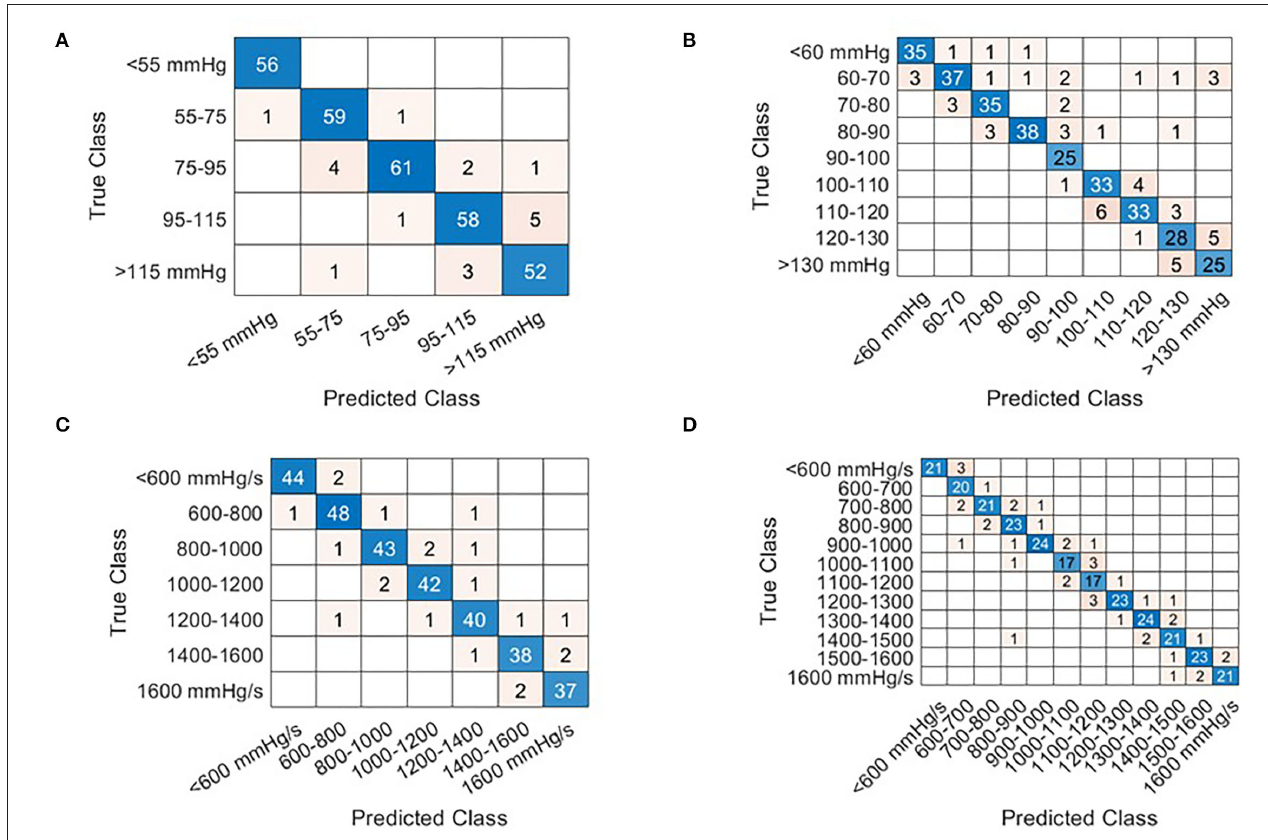
FIGURE 5 | Confusion matrices that illustrate the correctly and incorrectly estimation results for each given beat via holdout validation from the Mitral valve sensor. The row of the matrix corresponds to the true class while columns correspond to the predicted class. Diagonal entries correspond to correct estimates while off-diagonal entries represent incorrect estimates. The beats selected for holdout validation were selected at random. At low prevalence of cardiac cycles in any given category, the number of selected samples is reduced in favor of the training dataset. Examples are shown for LVPmax [ (A,B) Interval bins of 20 and 10 mmHg respectively] and LV dP/dt(max) (C,D) interval bins of 200 mmHg/s, (D) 100